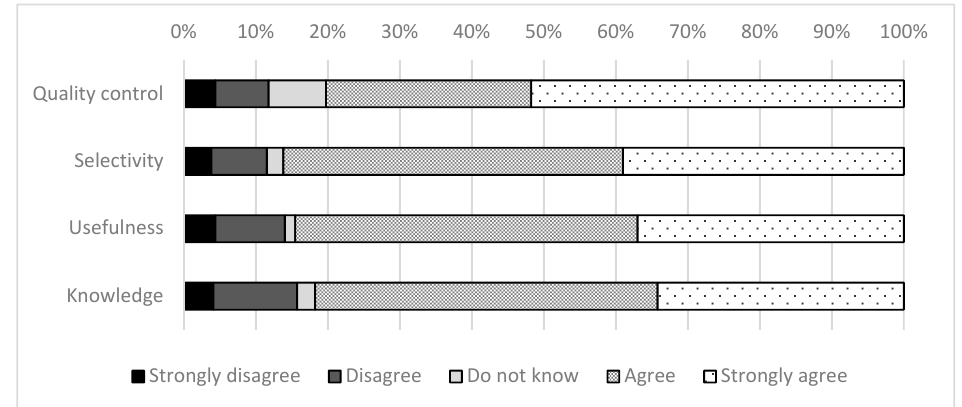
Figure 1. Audience attitudes towards journalistic gatekeeper functions related to editorial over- sight.